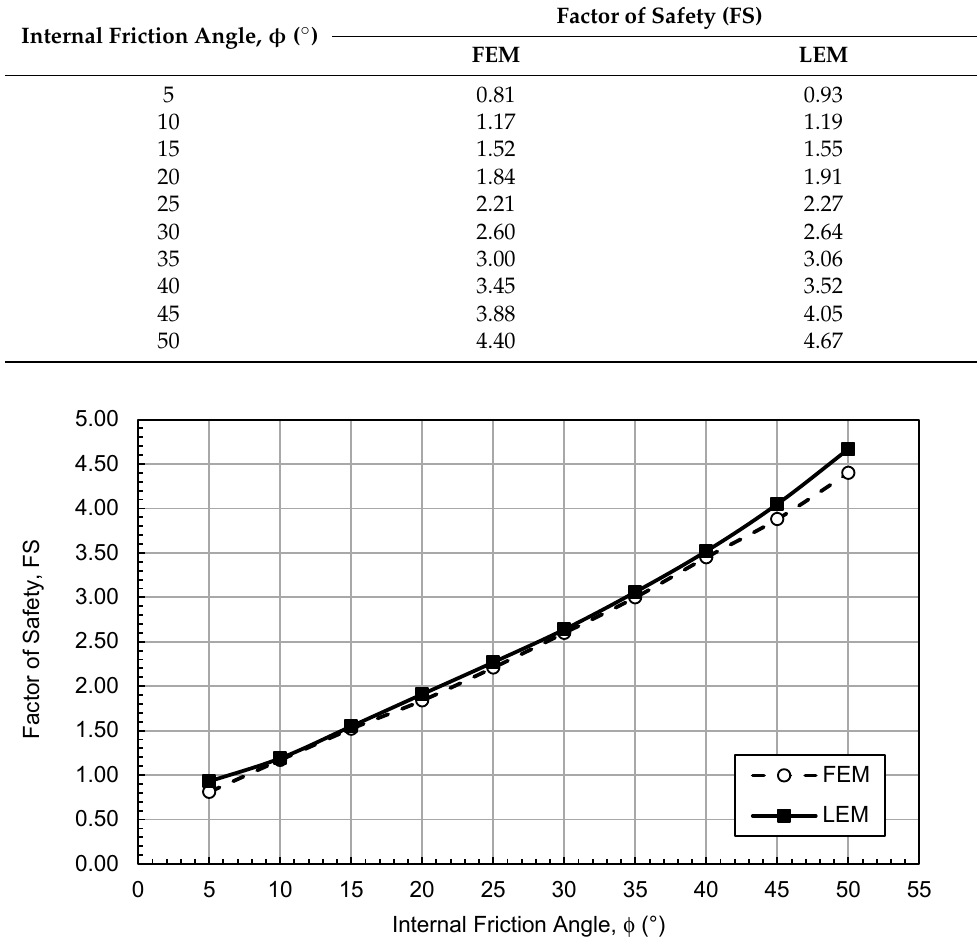
Table 3. Analysis results for different internal friction angle values.